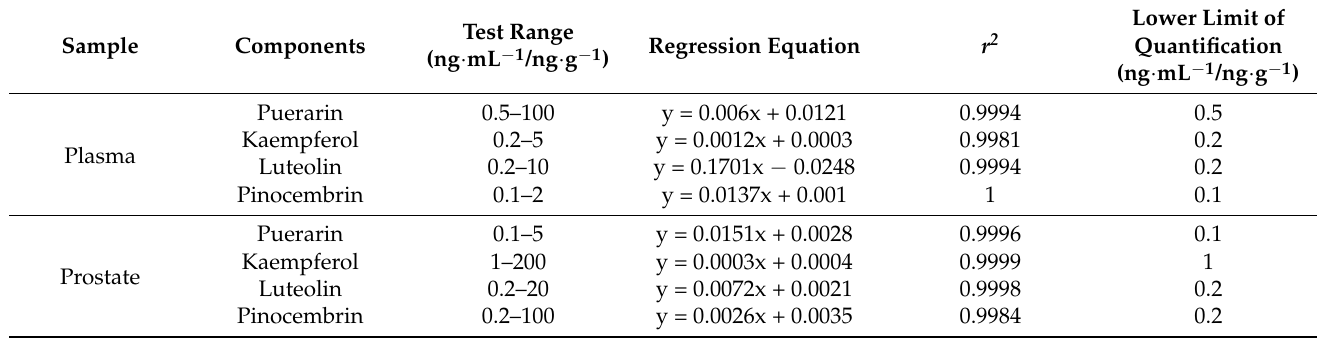
Table 3. Standard curve equations of four analytes in plasma and prostate ( n = 3).